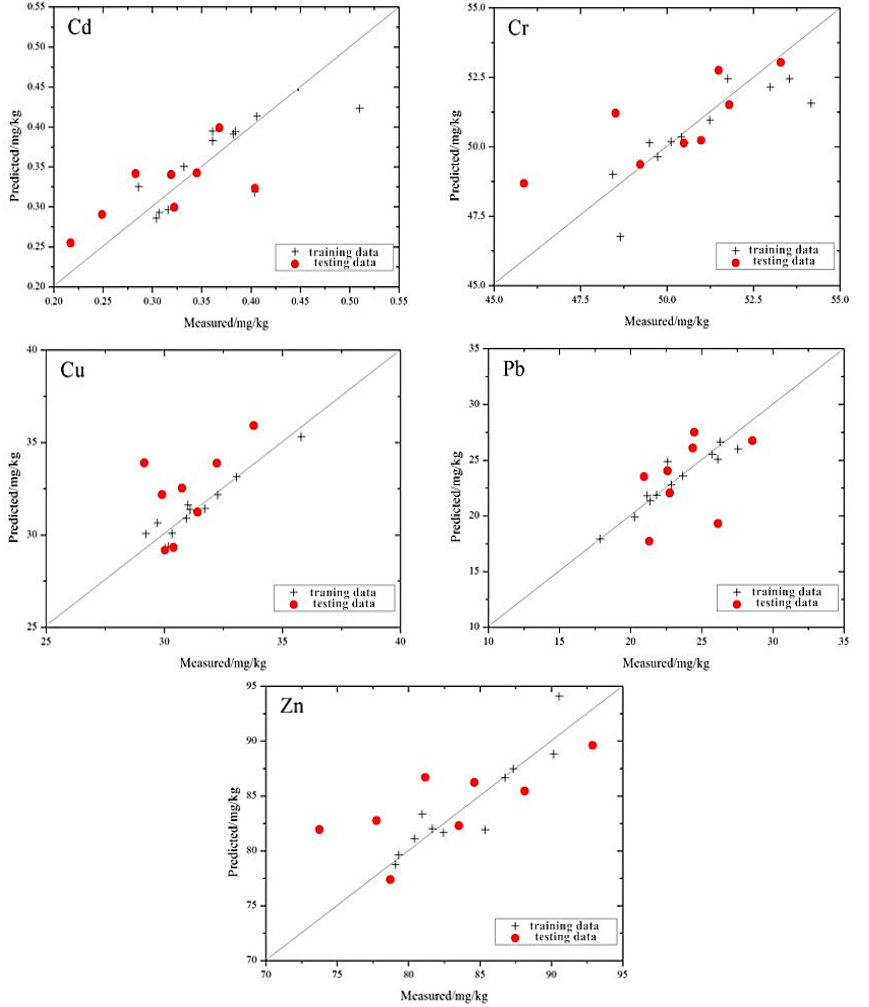
Figure 3. Individual points of heavy metal concentrations of the mine reclamation soils predicted by the MLR model plotted against the measured